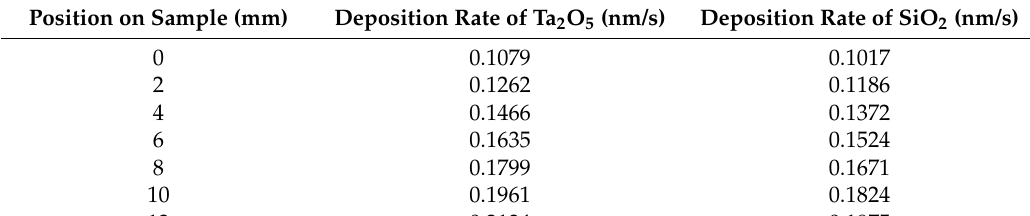
Figure 5. Film thickness mismatching error in sampling points.